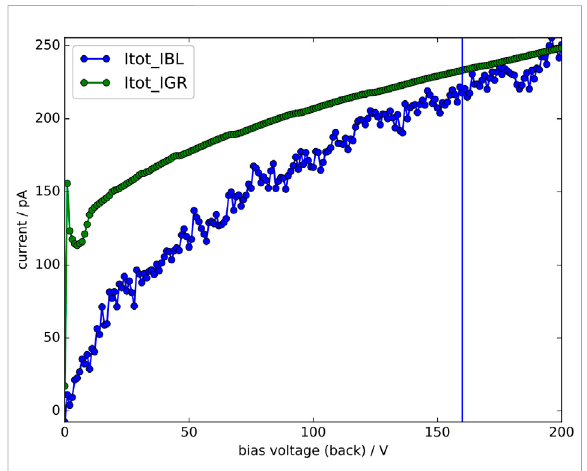
FIGURE 2 Example of the IV characterization of a complete sensors. The plot shows the current measured on the bias line (IBL, blue plot) and on the fi rst biased guard ring (inner guard ring IGR, green plot) as a function of the bias voltage applied on the entrance window. The sensor is produced on a 450 μ m thick wafer, with getteringprocessontheentrancewindow.Thesensorhas32DC- coupled strips plus 4 dummy strips at the borders, a strip pitch of 200 μ m and a strip length of 6 mm.